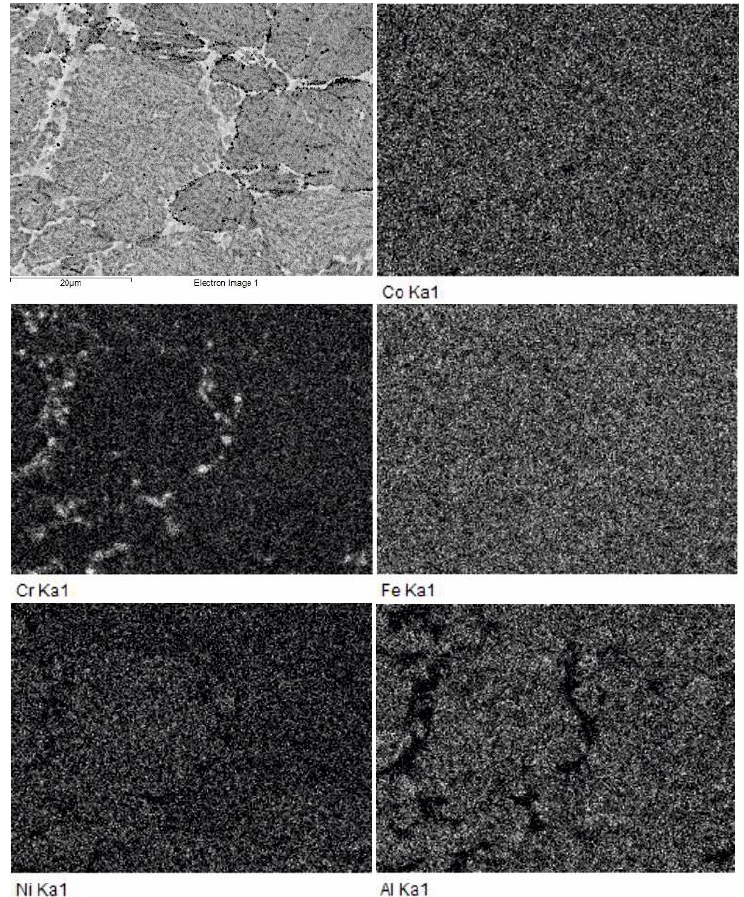
Figure 7. SEM image and X-ray mapping of the elements for a sample SPS-consolidated at 1100 °C.